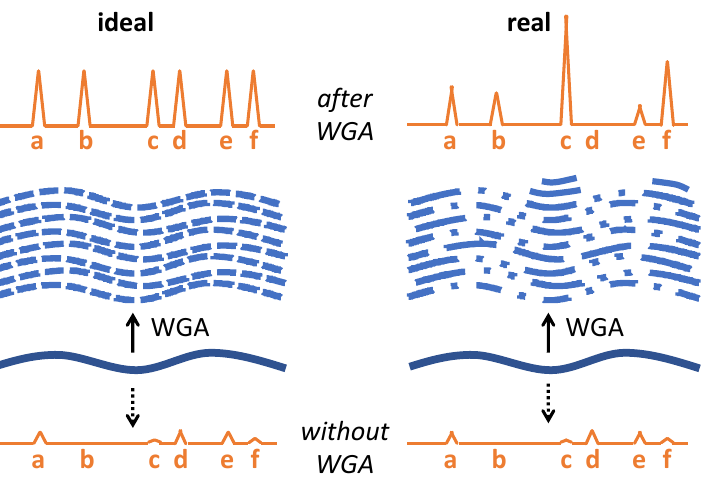
Figure 3. Consequences of WGA-inherent bias for STR typing. On the left side, the ideal situation is schematically depicted: WGA leads to even amplification of the complete template DNA, and the electropherogram shows a complete and balanced profile with high allele peaks ( a – f ), as compared to the incomplete LT DNA profile obtained without WGA (bottom). On the right, the real situation is depicted with uneven amplification, and consequently an imbalanced profile with ADOs (peak d). Please note that ADOs and AIs in LT DNA analysis without prior WGA are mainly due to stochastic sampling effects, whereas WGA-inherent bias causes additional AIs and